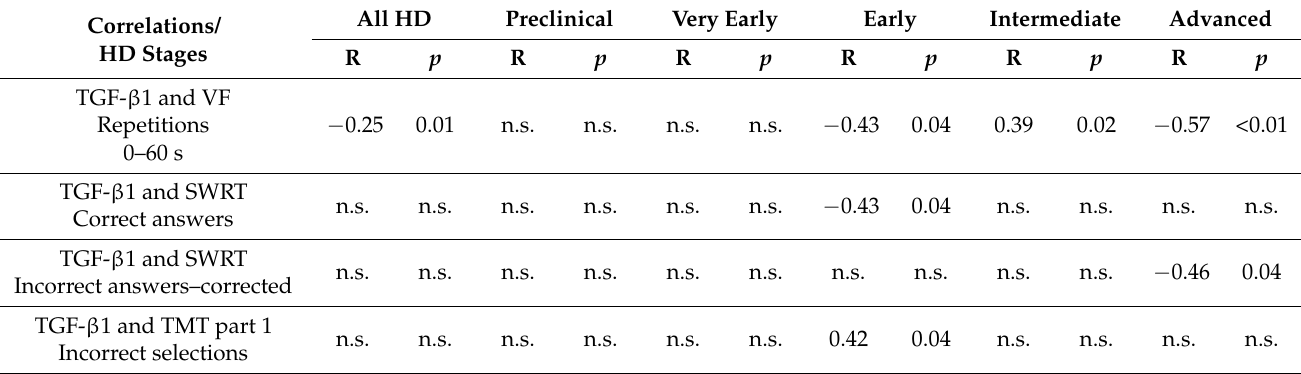
Table 7. Correlations between plasma levels of TGF- β 1 and cognitive functions determined with Spearman’s test. Correlations/ HD